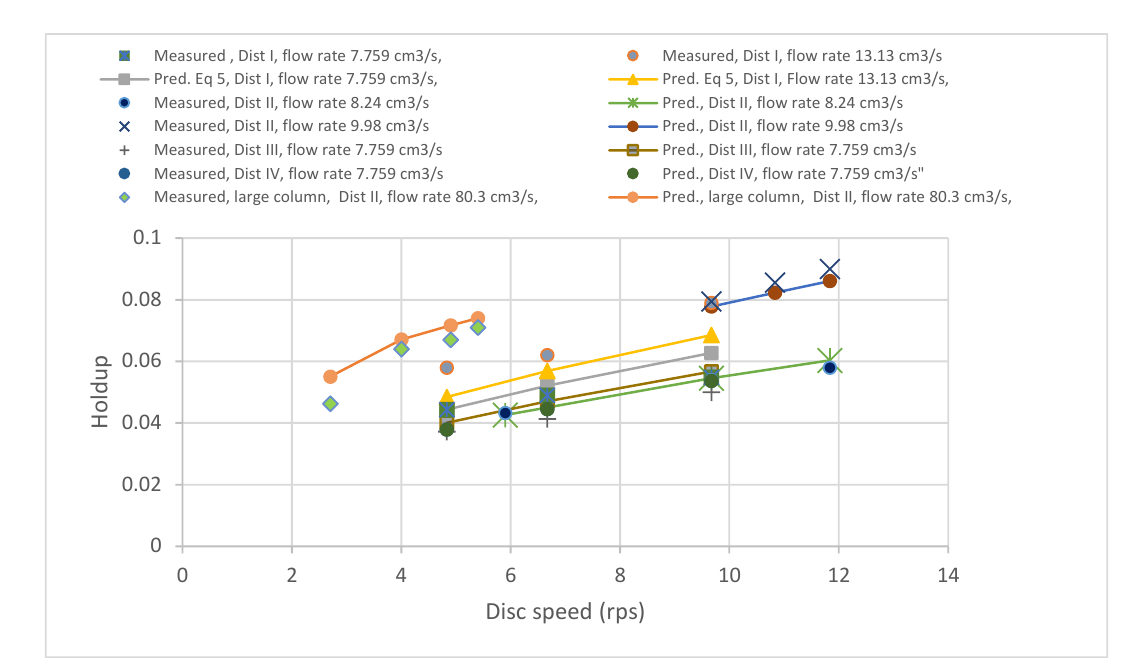
Figure 11. The measured and predicted dispersed phase holdup values (from Equation (5)) obtained from the small and large columns, for different distributors and operating conditions.